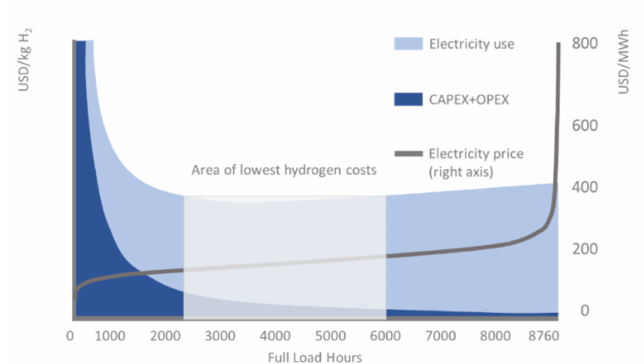
Figure A1. Levelized Cost of Hydrogen (LCOH) as a function of annual full load hours. Up to 2500 h, CAPEX costs dominate and costs are decrease, OPEX other than electricity decreases as well and is included in CAPEX + OPEX. Above 6000 h OPEX related to electricity is most important. The optimum for this example case is between 2500 and 6000 h. (adapted from [81] with permission from IEA 2019).